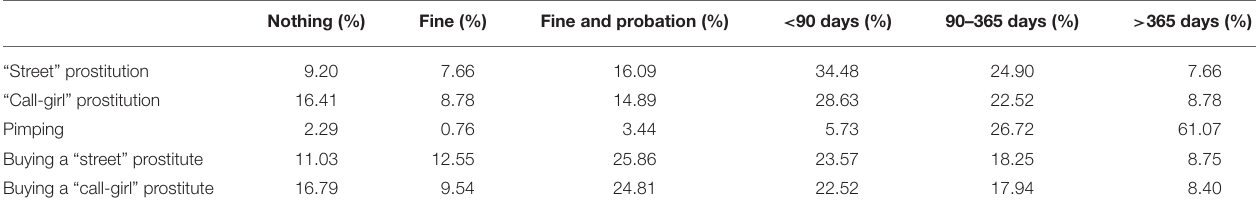
TABLE 3 | Officer perceptions of appropriate sanctions for various prostitution offenses.